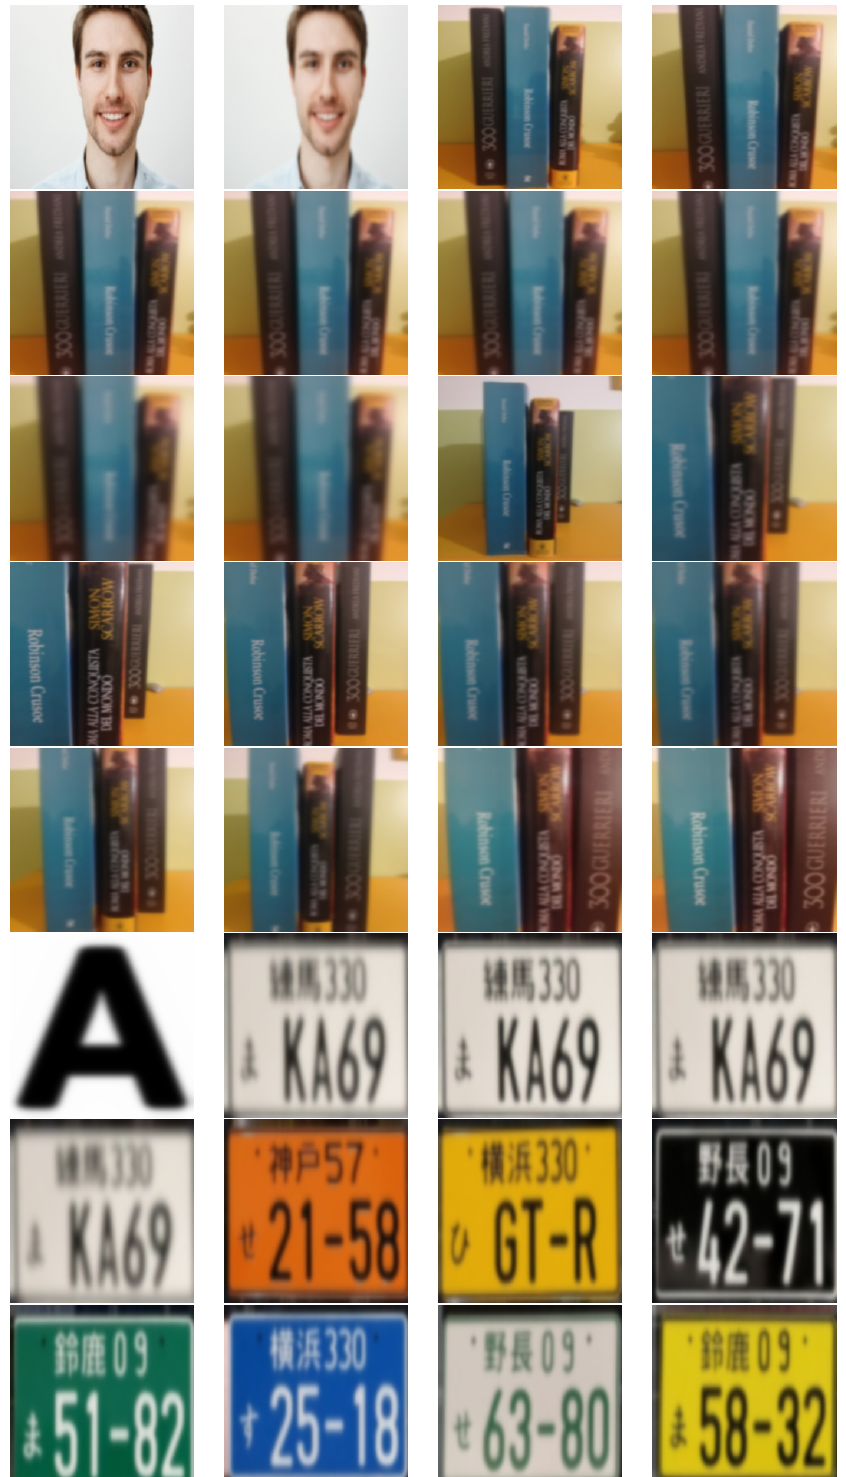
Figure 12. Thirty-two (out of thirty-three) test images used in the first comprehensive set of ex- periments. The colored images were turned grey-level by keeping the first channel of their RGB representation while discarding the remaining two